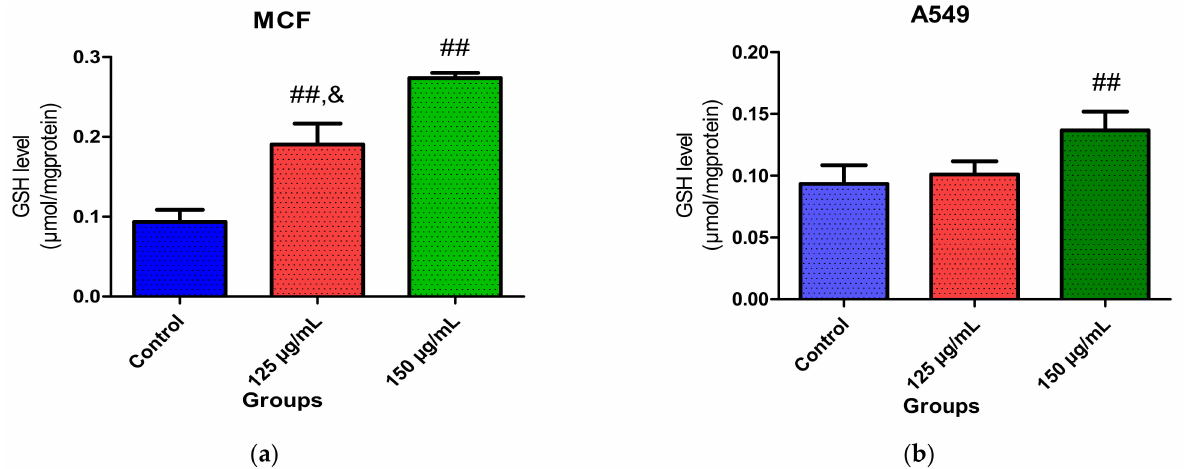
Figure 5. Effect of PUFA-rich extract from Chlorella sp. on GSH levels in ( a ) MCF-7 and ( b ) A549 cells after incubation for 48 h. Bars represent mean ± SEM. Values are statistically different at ## p < 0.05 vs. control; & p < 0.05 vs. 150 µ